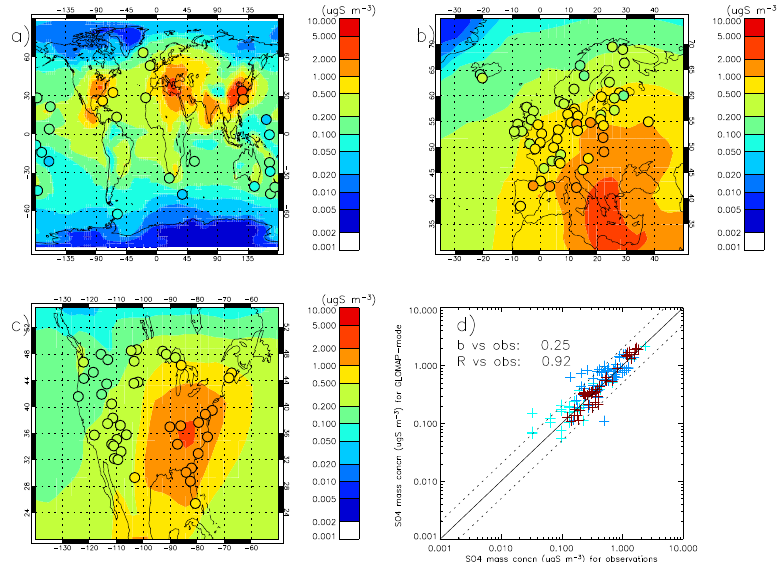
Fig. 5. Maps of simulated annual-mean sulfate concentration in the lowest model level (a) globally, (b) over Europe and (c) over North America with year-2000 surface observations from sites in the University of Miami, EMEP and IMPROVE networks respectively over- plotted. Scatter plots for the model (y-axis) compared to the observations (x-axis) are shown in panel (d) with cyan, blue and red plus symbols corresponding to the University of Miami, EMEP and IMPROVE regions respectively. b and R values shown in panel d are for the the model-observation comparison over all three networks. Observations are for the year 2000 with only sites where the height above sea-level is within 250m of that calculated for the lowest model level included.